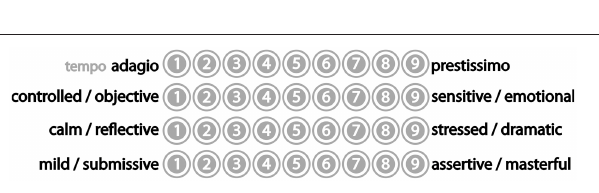
FIGURE 4 | Four music characteristics